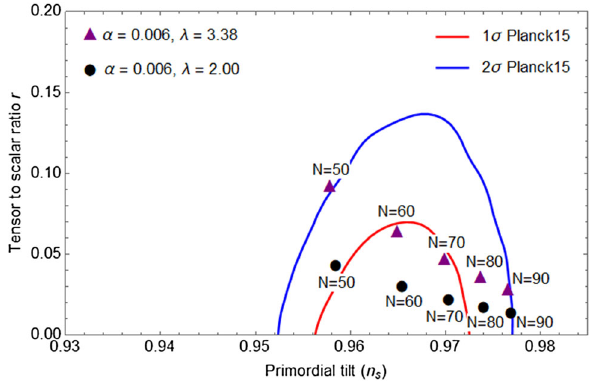
Fig. 3 We compare the theoretical predictions in the ( r − n s ) plane for different values of λ and N but keep α fixed with Planck’15 results for TT, TE, EE, +lowP and assuming (cid:18) CDM+ r [5]